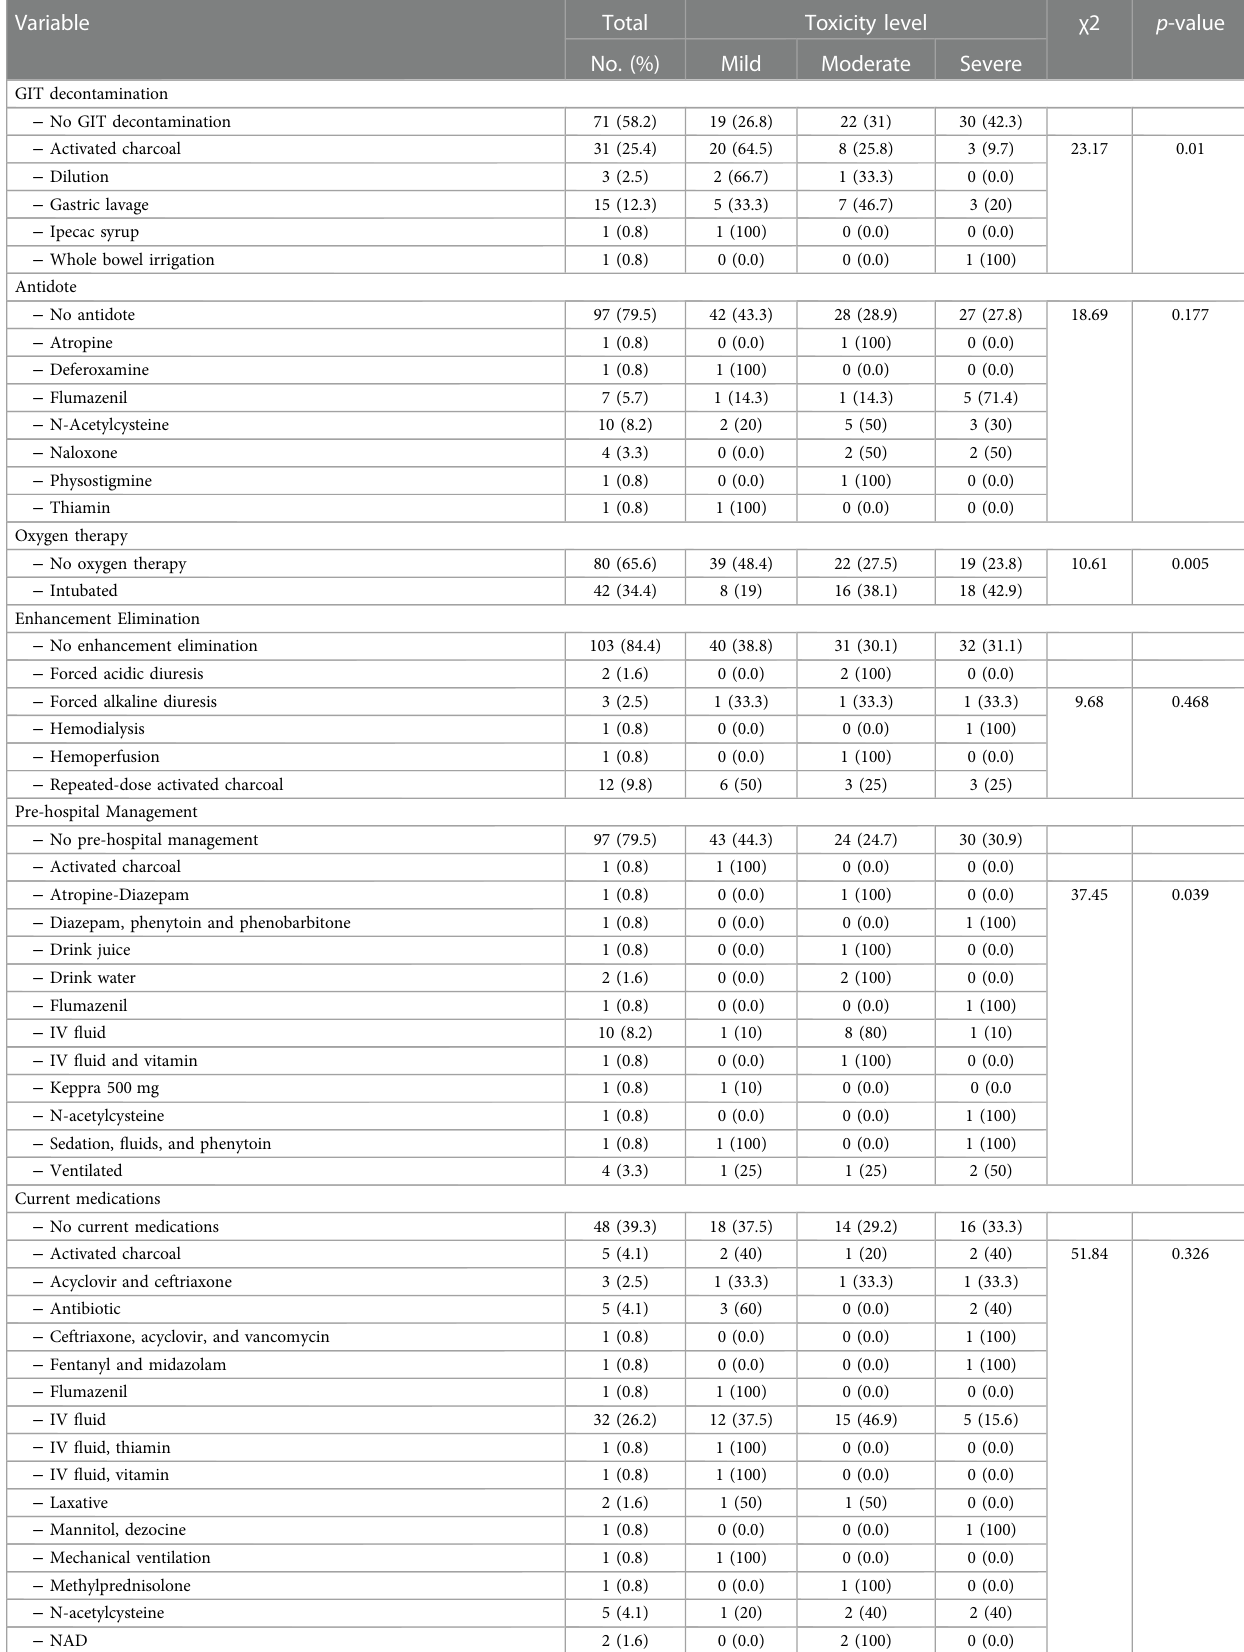
TABLE 4 Relationship between GIT decontamination, antidote, oxygen therapy, enhancement elimination, pre-hospital management, and current medications and level of toxicity.